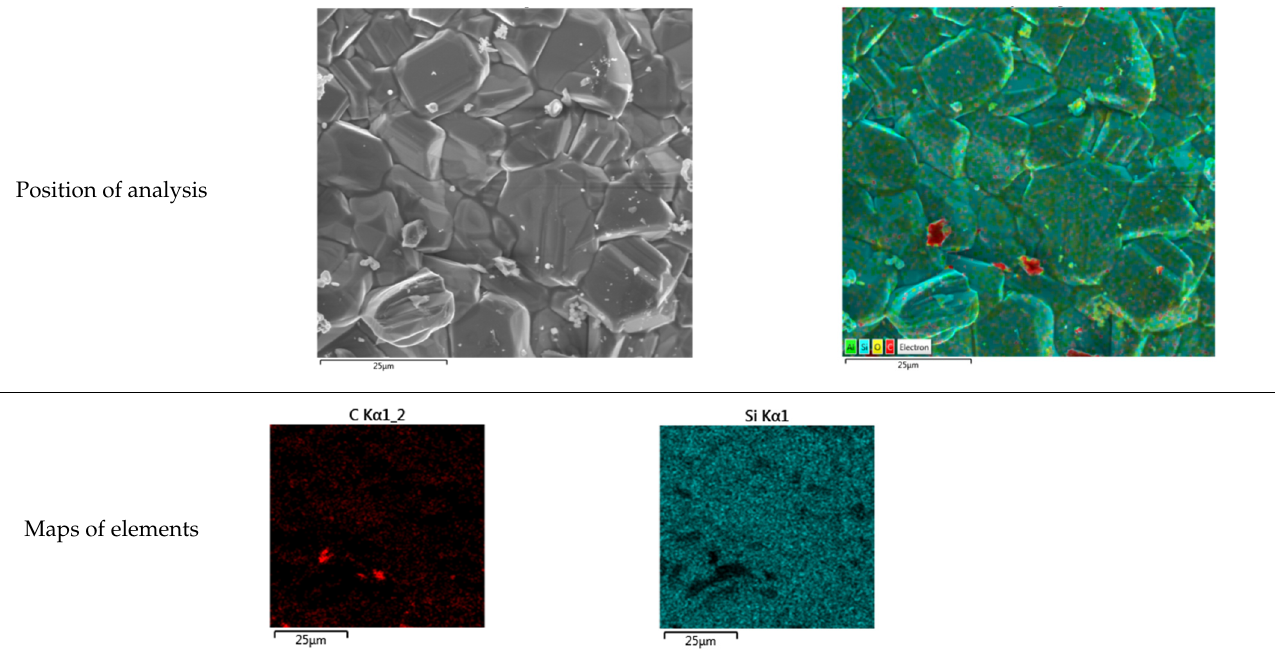
Table 8. Microscopic analysis of product (Silicon Carbide — SiC) after carbothermic reduction of quartz Macedonia at 1800 °C.